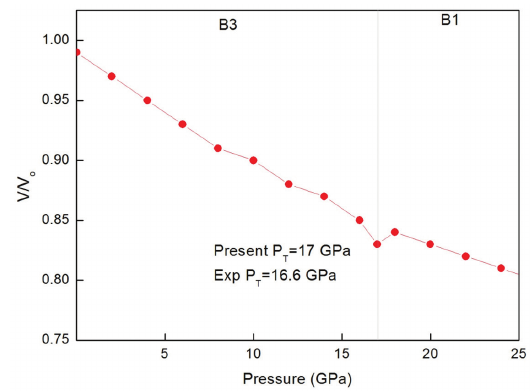
Figure 1. P-V plot of GaAs up to 25 GPa.